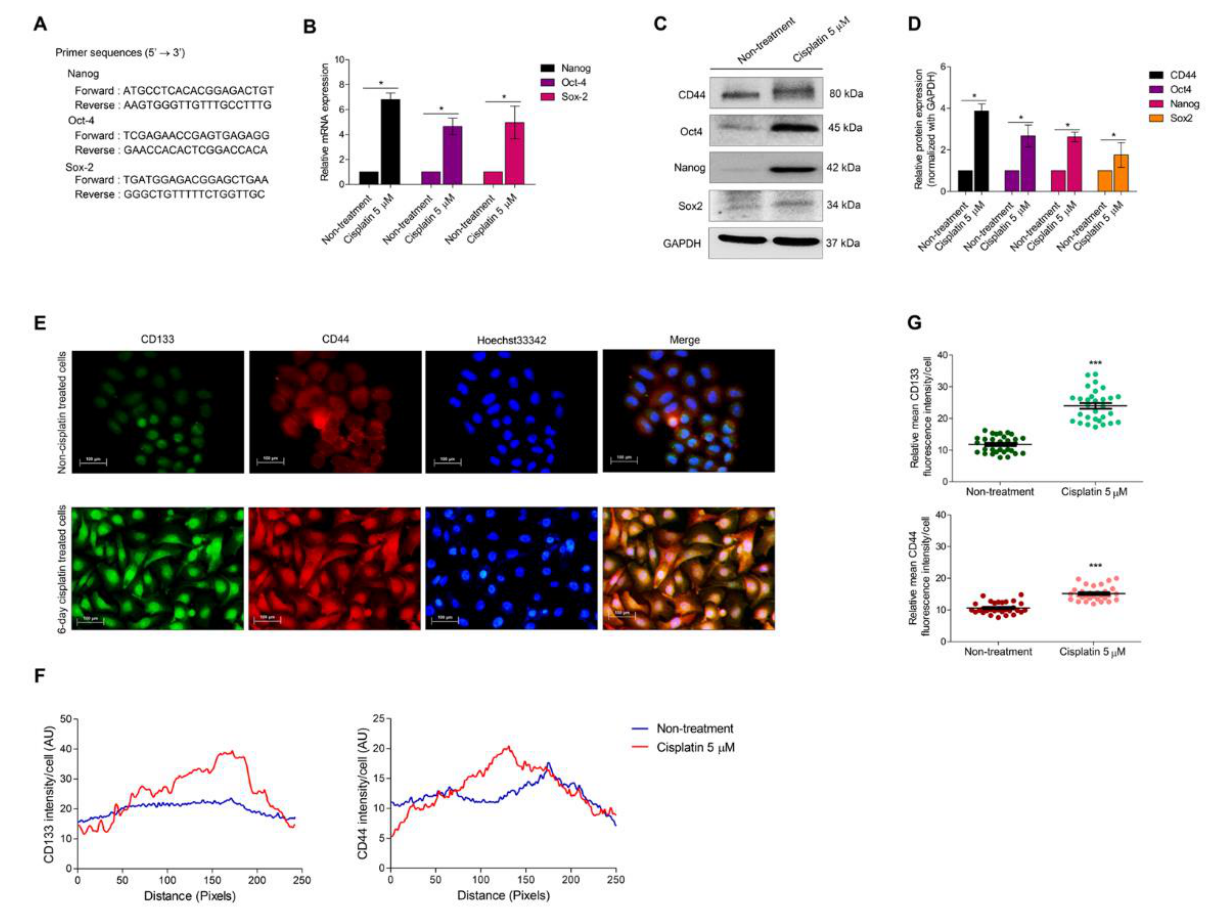
Figure 4. ( A ) The sequences of Nanog, Oct-4, and Sox-2 primers for RT-PCT were presented. ( B ) mRNA levels of pluripotent markers, Nanog, Oct-4, and Sox-2, were examined in H460 and cisplatin-treated cells. Relative mRNA expression levels were calculated and compared with the non- treated control. ( C , D ) Western blot analysis was performed to confirm the stemness and pluripotent- related proteins in H460 senescent cells compared with the H460 non-treated control. GAPDH was measured to normalize the equal loading of each protein sample. The densitometry of each protein level was demonstrated as a relative protein level. ( E ) To confirm the inducing stem-like phenotype, the protein expression of CD133 and CD44, which are stemness markers, was evaluated using an ICC assay. ( F ) The fluorescence intensity per cell was measured. ( G ) The relative mean intensity per cell was calculated. Data represent the mean ± SEM ( n = 3) (* 0.01 ≤ p < 0.05 and *** p < 0.001, compared with the non-treated